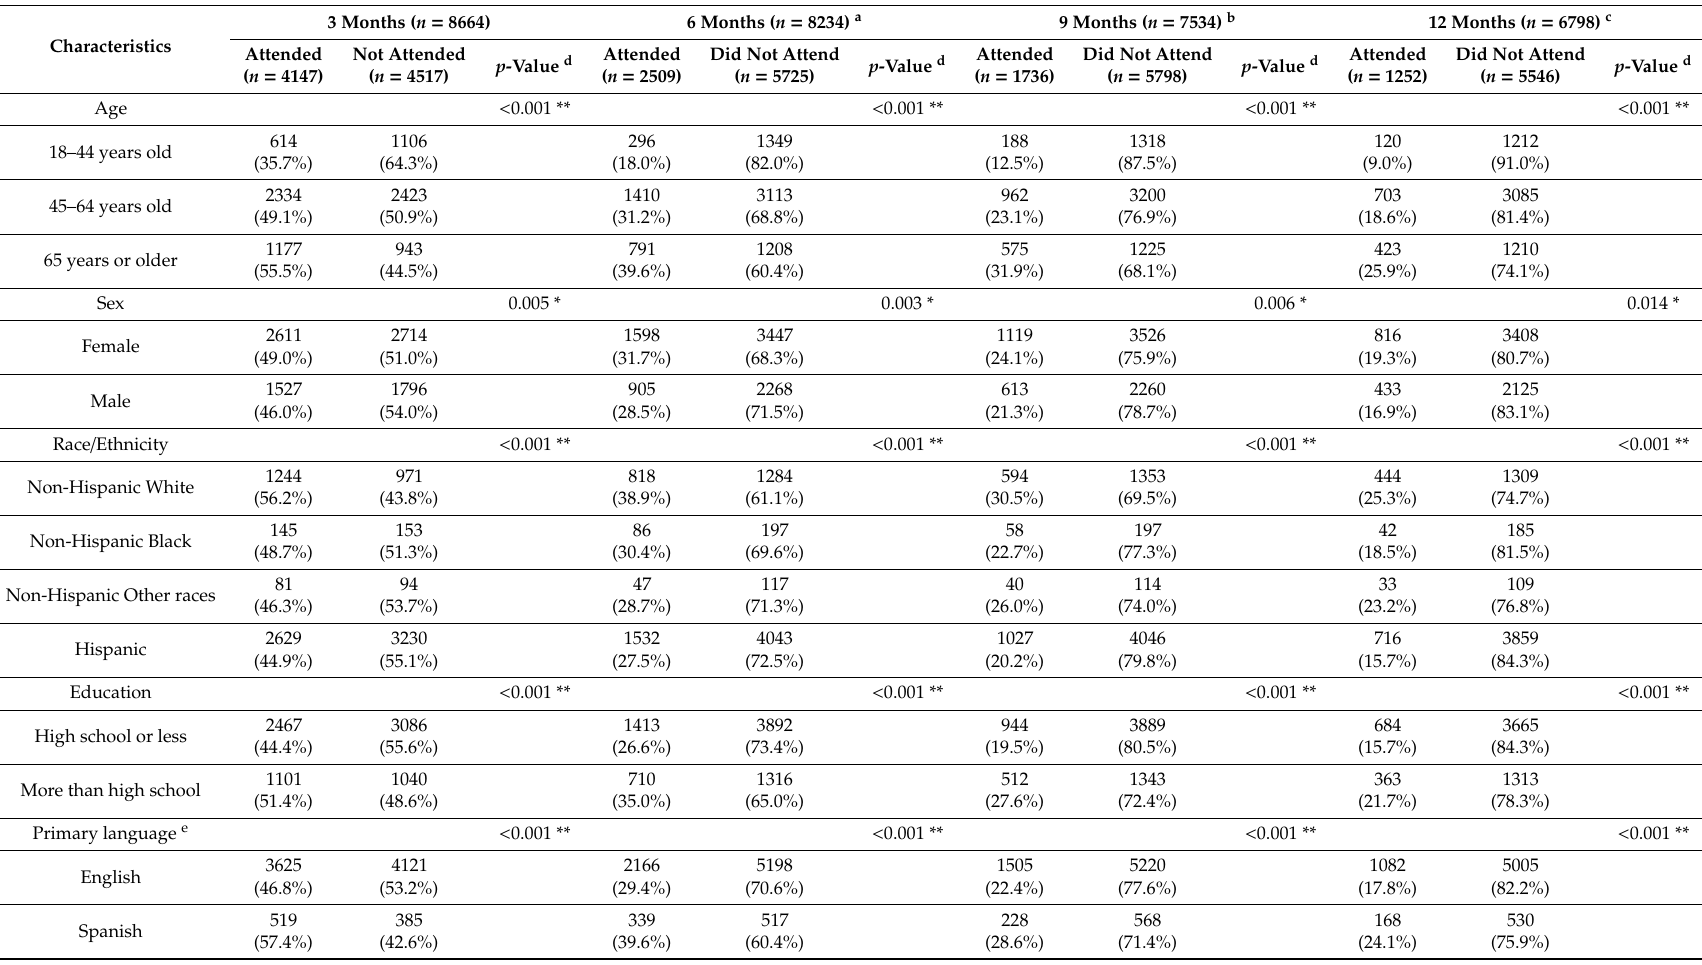
Table 2. Characteristics of the program participants who attended and did not attend 3-, 6-, 9-, and 12-month follow-up